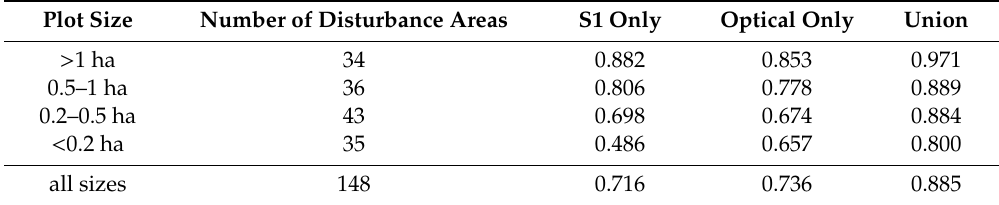
Table 3. Detection accuracy per disturbance patch size for Peru.